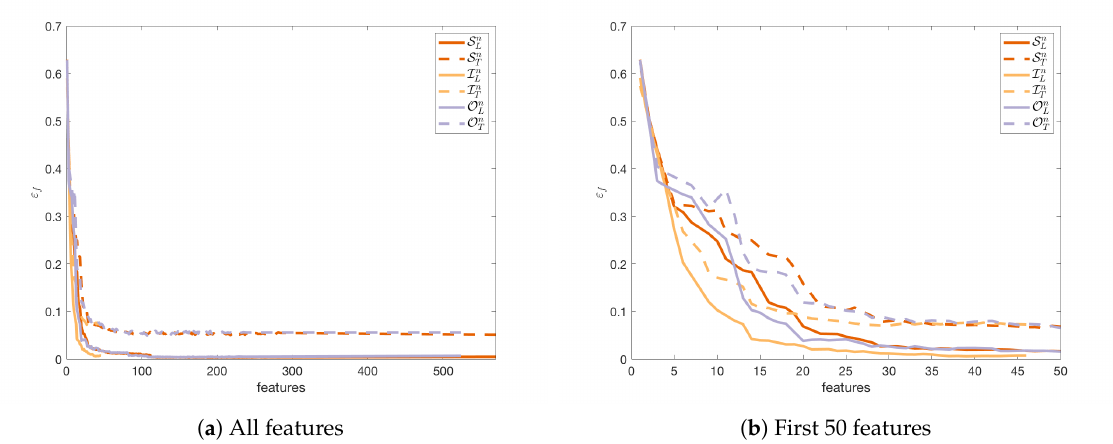
Figure 8. The dependence between the number of features and the obtained classification error for the floor’s predictions ε f